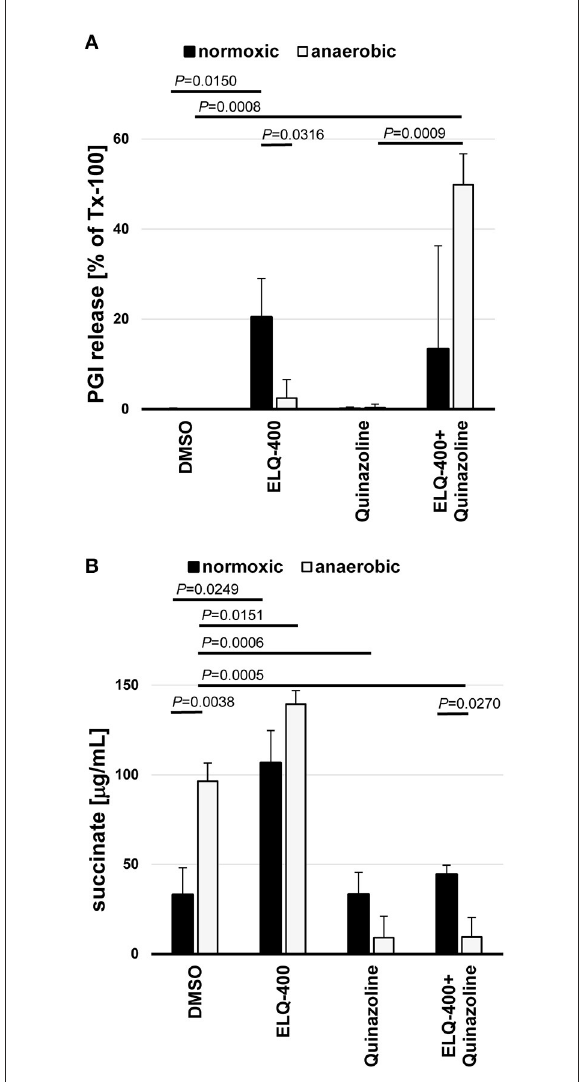
FIGURE6 Double-inhibition of the bc 1 complex and the malate dismutation of E. multilocularis metacestodes and GL cells. E. multilocularis metacestodes were treated with ELQ-400 (10 µ M) and or quinazoline (10 µ M) for 5 days and PGI release assessed as a quantifiable damage marker in relation to meteacestodes treated with the internal positive control Tx-100 (A) . From the same setup, released succinate levels were assessed for each condition by Succinic Acid Assay Kit. Incubations were performed under normoxic (21% O 2 ) and anaerobic (0% O 2 ) conditions in parallel. DMSO treatment was used a negative control (B) . Experiments were performed in biological triplicates, and mean values with standard deviations are given for the relative PGI release (A) and the succinate levels (B) . P -values are given for significant differences with P < 0.05.